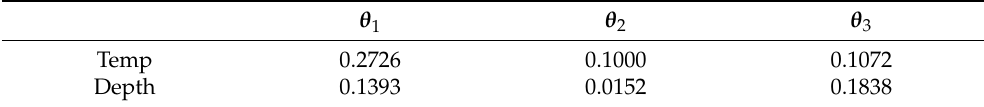
Table 5. Parameters of unbiased Kriging